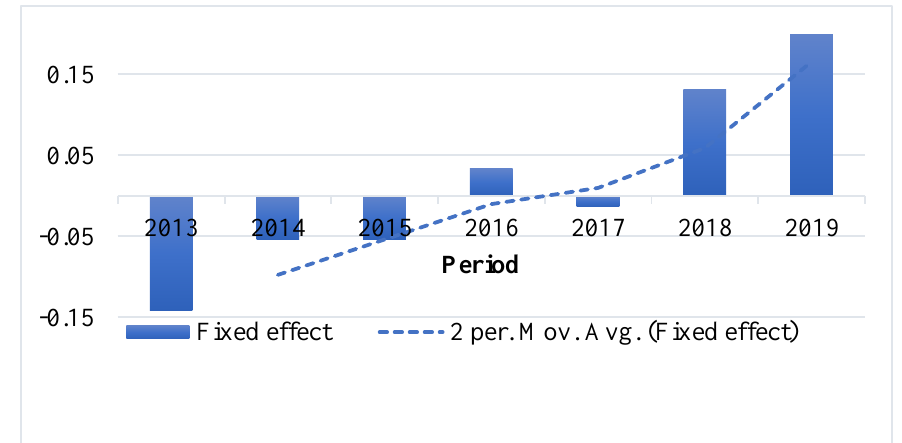
Figure 7. Fixed effects generated by evolution over time. Source: authors’ calculation.